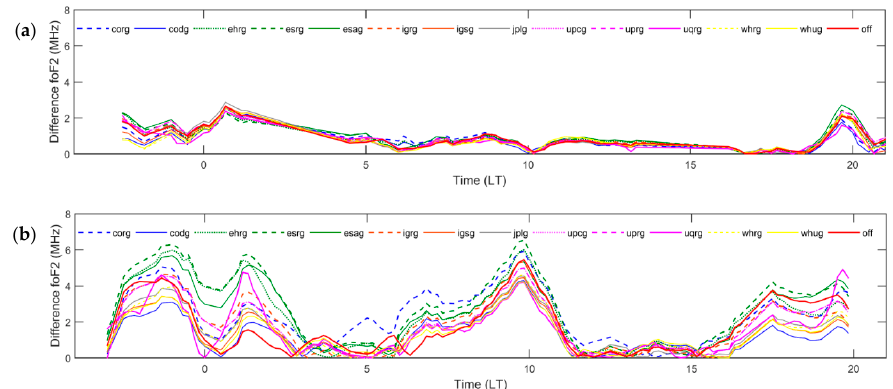
Figure 6. Differences between fo F 2 values measured at the ionosondes and estimated using GIMs, for two pairs of ionosondes: ( a ) FZA0M and SAA0K, the closest one; ( b ) CAJ2M and BVJ03, the most distant one.